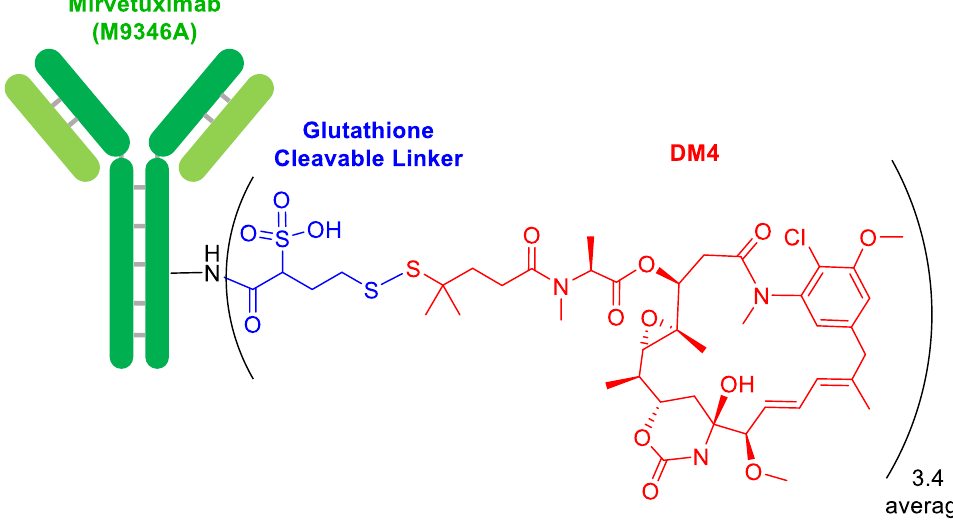
Figure 2. Structure of mirvetuximab soravtansine-gynx.